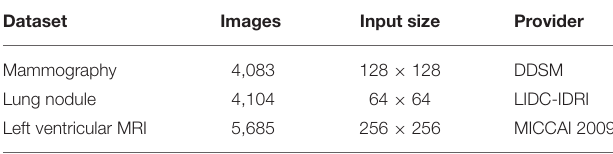
TABLE 2 | The medical image segmentation datasets used in our experiments.